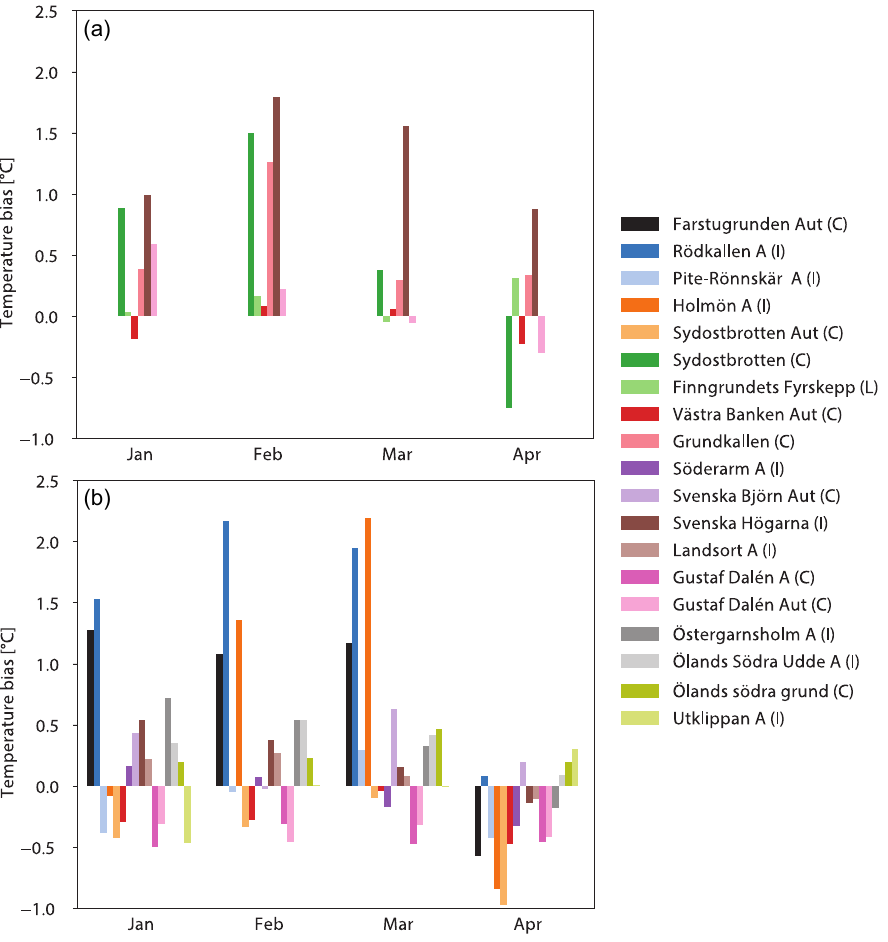
Figure 2. Long-term monthly mean January–April 2m air temperature bias ( ◦ C). The bias is calculated for before 1979 (a) and after 1979 (b) ; the stations are arranged in an approximately north-to-south order going from the leftmost to the rightmost bar in each month. A positive bias means that the model air temperature forcing is warmer than the observations. After each name the type of measurement platform is given. C: Cassion Lighthouse; L: Lightship; I: